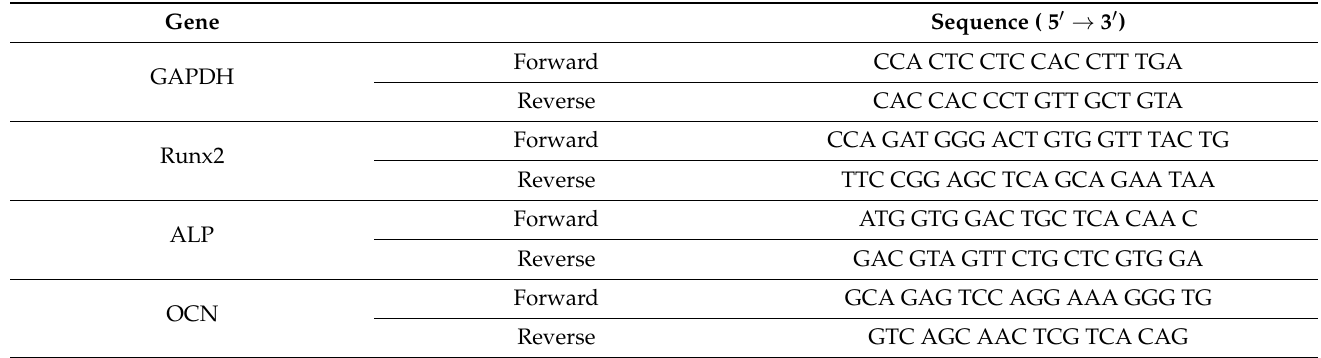
Table 1. Details of the primers used in this